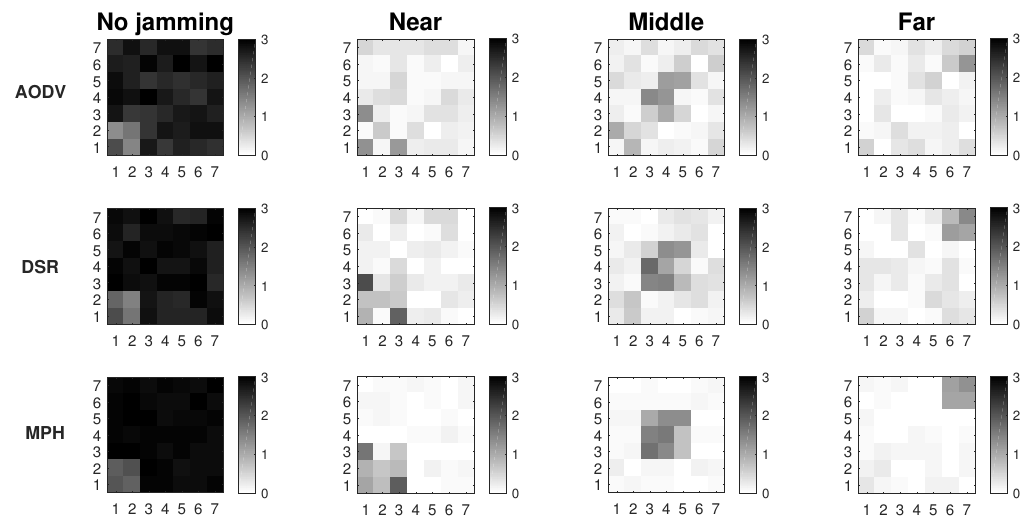
Figure 8. Comparison for AODV, DSR, and MPH protocols under Scenario 3.